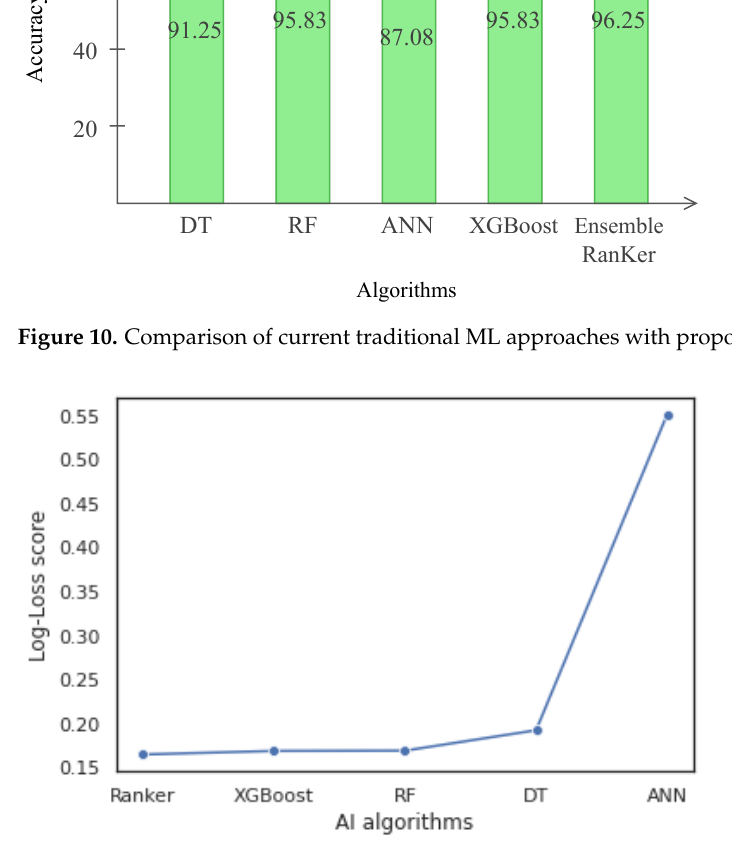
Figure 11. Log-loss score